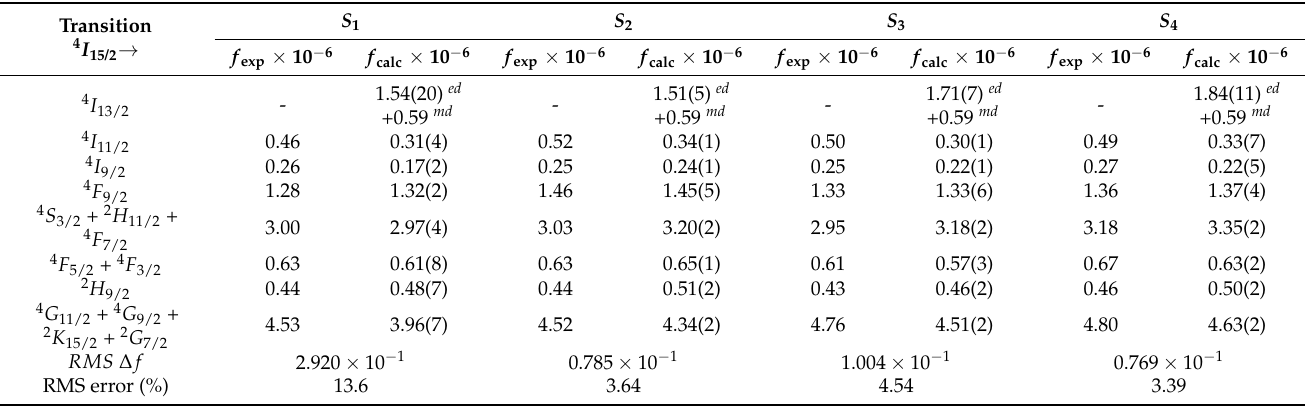
Table 3. Values of the measured and calculated absorption oscillator strengths of Er 3+ in the YAG (YSAG) ceramic samples at 300 K; ed is electric dipole transition, md is magnetic dipole one.